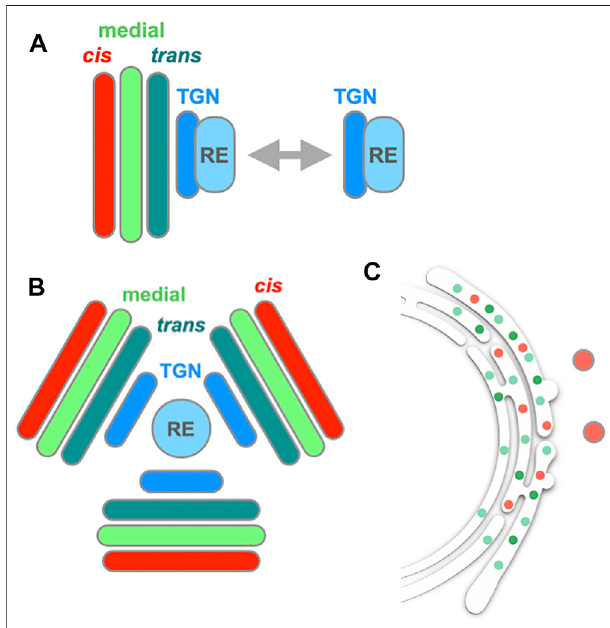
FIGURE4| |BehavioroftheGolgi,TGNandREinDrosophilacells. (A) In Drosophila S2 cells, Golgi stack ( cis , medial, and trans ) and RE (recycling endosome) show attachment and detachment repeatedly (Fujii et al., 2020a). TGN appears to behave together with RE. Similar behavior of RE is also seen in nocodazole-treated HeLa cells. (B) When S2 cells are treated with BFA,whichinhibitsArfGEFSec71,Golgi,TGNandREformalargeaggregate (BFAbody).IntheBFAbody,REsitsatthecenter,TGNfollowsnextandGolgi cisternae align from trans to cis toward the periphery. (C) When the other Arf GEF of Drosophila Garz, which is insensitive to BFA, is knocked down, the Golgi main body is mostly absorbed into the ER, while leaving behind a cis component (GM130, red spots) (Fujii et al.,